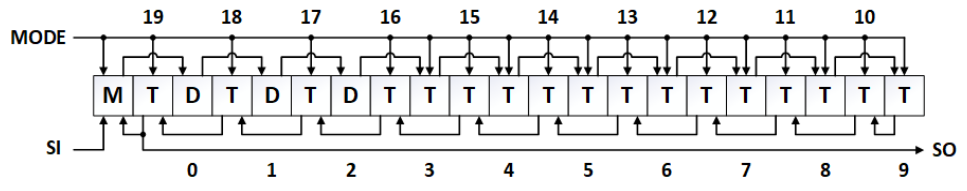
Figure 14. Topology layout for a 20-bit DT-LFSR register with the D 3 T 17 structure and designed by means of the interleaving